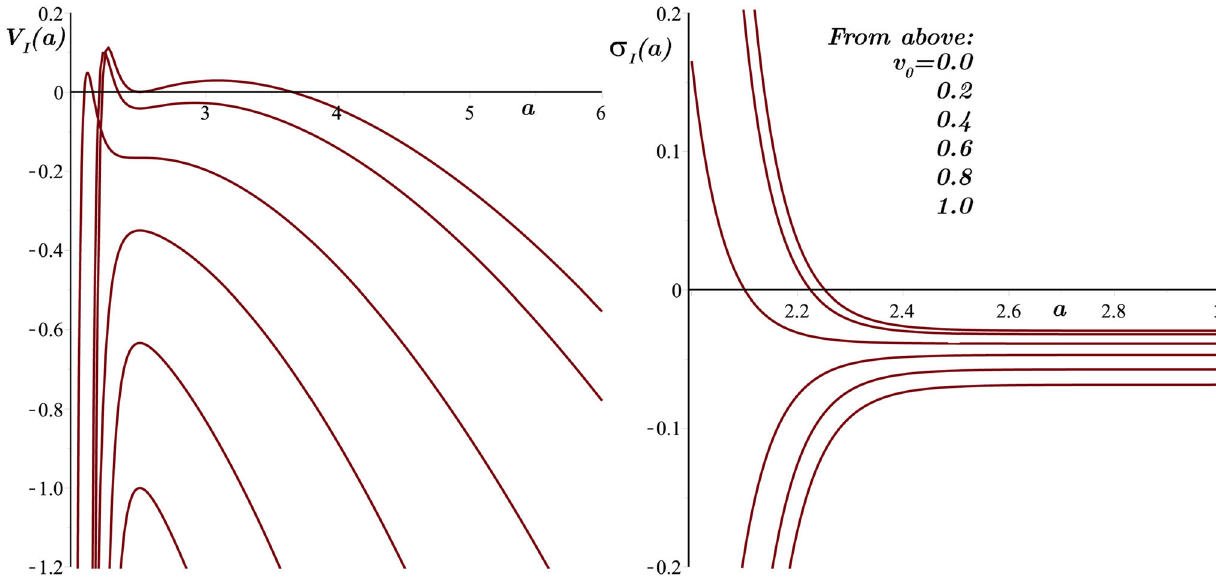
= 16, M = 1 the surface energy density is negative in the region where the motion 0 is physically possible. The stable STSW corresponding to the linear stability analysis, becomes unstable with v 2